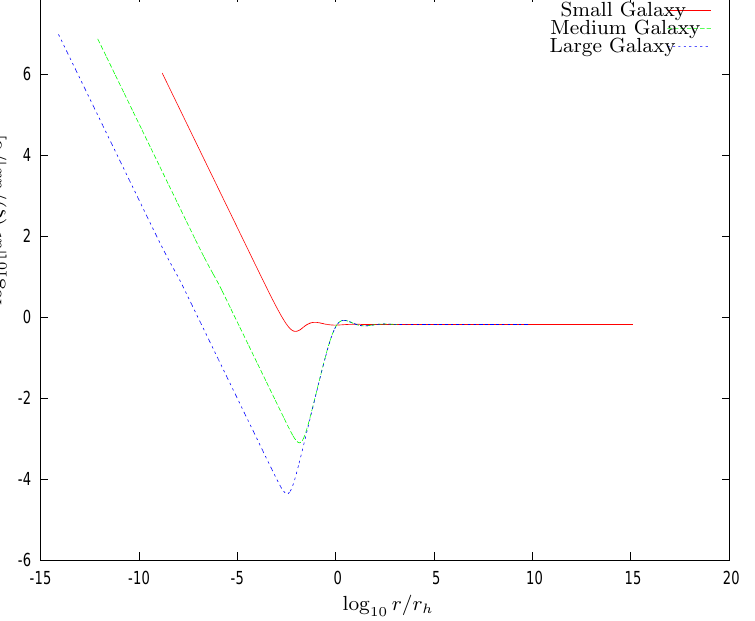
[ d ν ( ξ ) / dx Figure 2. The derivative of the dimensionless chemical potential log /3 ] vs. [ dν ( ξ ) /dx / 3] vs. log ( ξ/ξ h ) = log ( r/r h ) for the three 10 10 10 10 | | | | dν ( ξ ) /dx follow the behaviour dictated by ( ξ / ξ h ) = log ( r / r h ) for the three galaxy solutions with central SMBHs defined by log | | 10 10 dν ( ξ ) /dx are dominated d ν ( ξ ) / dx | | Equation (74). For r (cid:46) r i , both ν ( ξ ) and follow the behavior dictated by the central | | black hole. r i is the influence radius of the BH defined by Equation (31). For r (cid:38) r i , ν ( ξ ) and d ν ( ξ ) / dx , they are dominated by WDM and exhibit a similar behavior to that for the Thomas–Fermi | | galaxy solutions without a central black hole